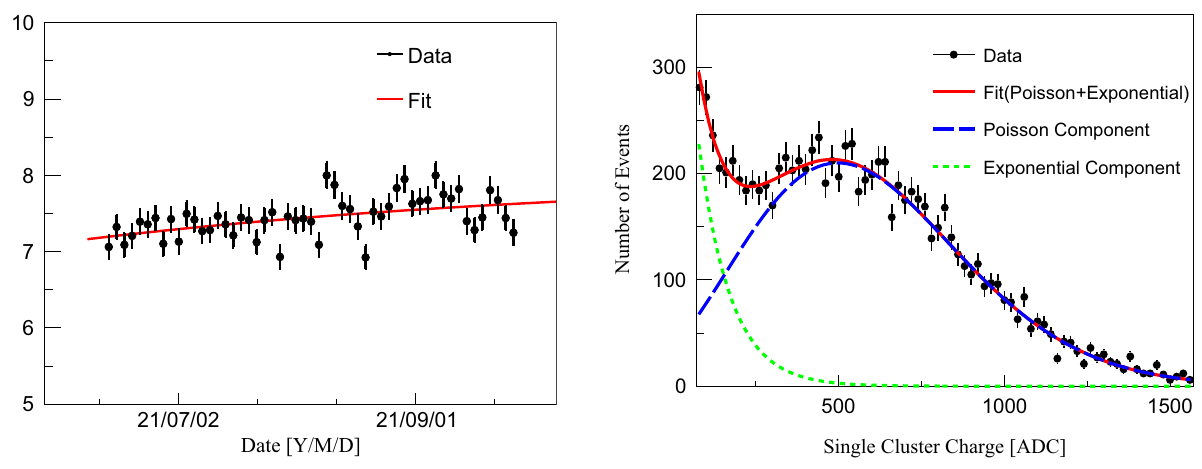
Fig. 13 Single cluster charge spectrum of one PMT attached to the NEO-5 crystal is modeled with exponential backgrounds (pedestal and low-gain dark current, green dashed line) and single photoelectron (Poisson component, blue long dashed